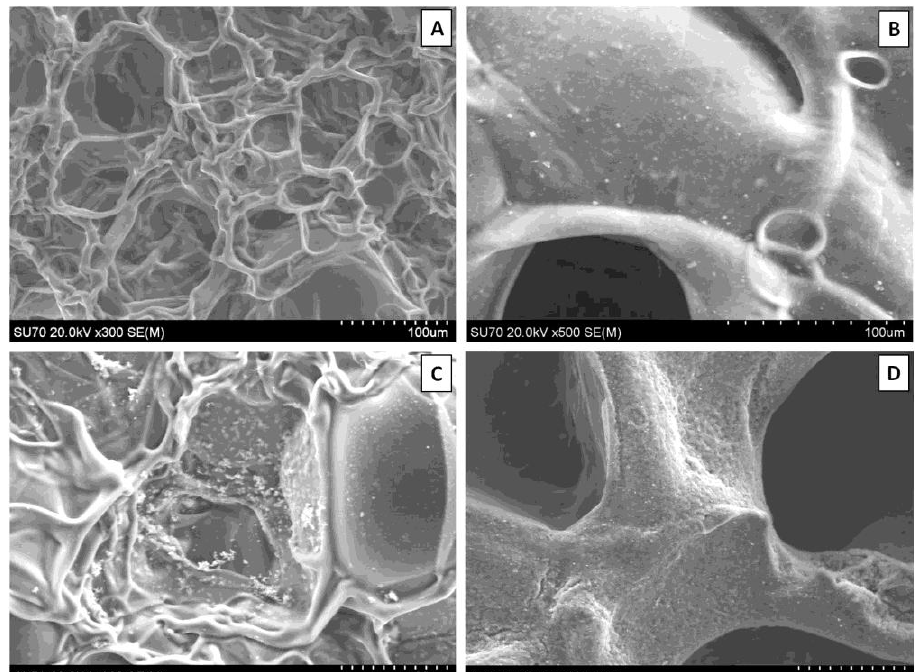
Figure 2. Scanning electron microscope (SEM) images of ( A ) GE, ( B ) PHCE, ( C ) GE-M, and ( D ) PHCE-M scaffold surfaces (Scale bars at 100 µm). Non-mineralized GE sponges ( A ) had smaller pores and a more uniform/smooth surface compared to PHCE sponges ( B ) which exhibited larger pores and a coarser surface as a result of the incorporated nanofillers. GE scaffolds sparsely nucleated crystals upon mineralization ( C ) while PHCE scaffolds uniformly nucleated a layer of minerals on the surface ( D